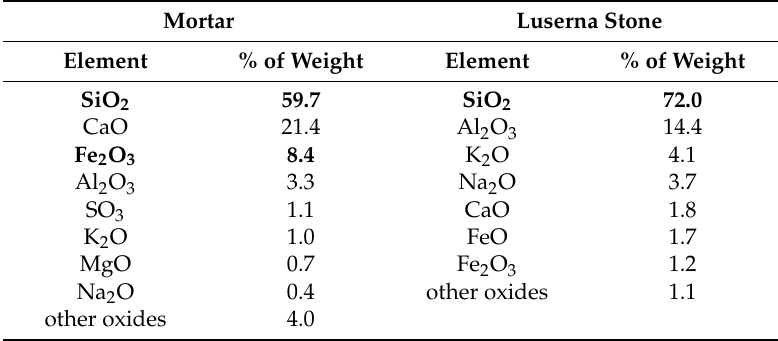
Table 1. Chemical composition of mortar enriched with ferric oxide and Luserna stone. Weight percentage of silicon dioxide and ferric oxide added (mortar) is highlighted.